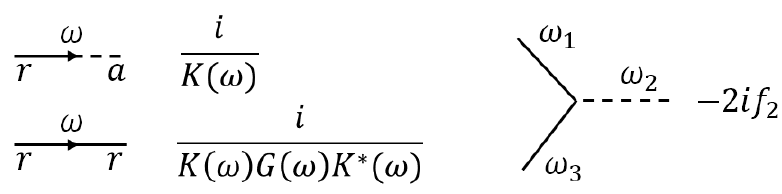
Figure 3 . Feynman rules for (3.10). Dashed lines correspond to x a , solid lines correspond to x .